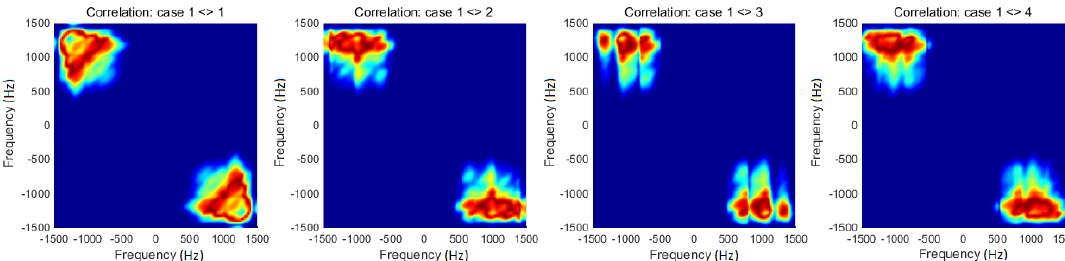
Figure 13. The p-values related to the correlation coefficients in Figure 12b. Extended frequency ranges are adopted to show relevant values at domain extremes.